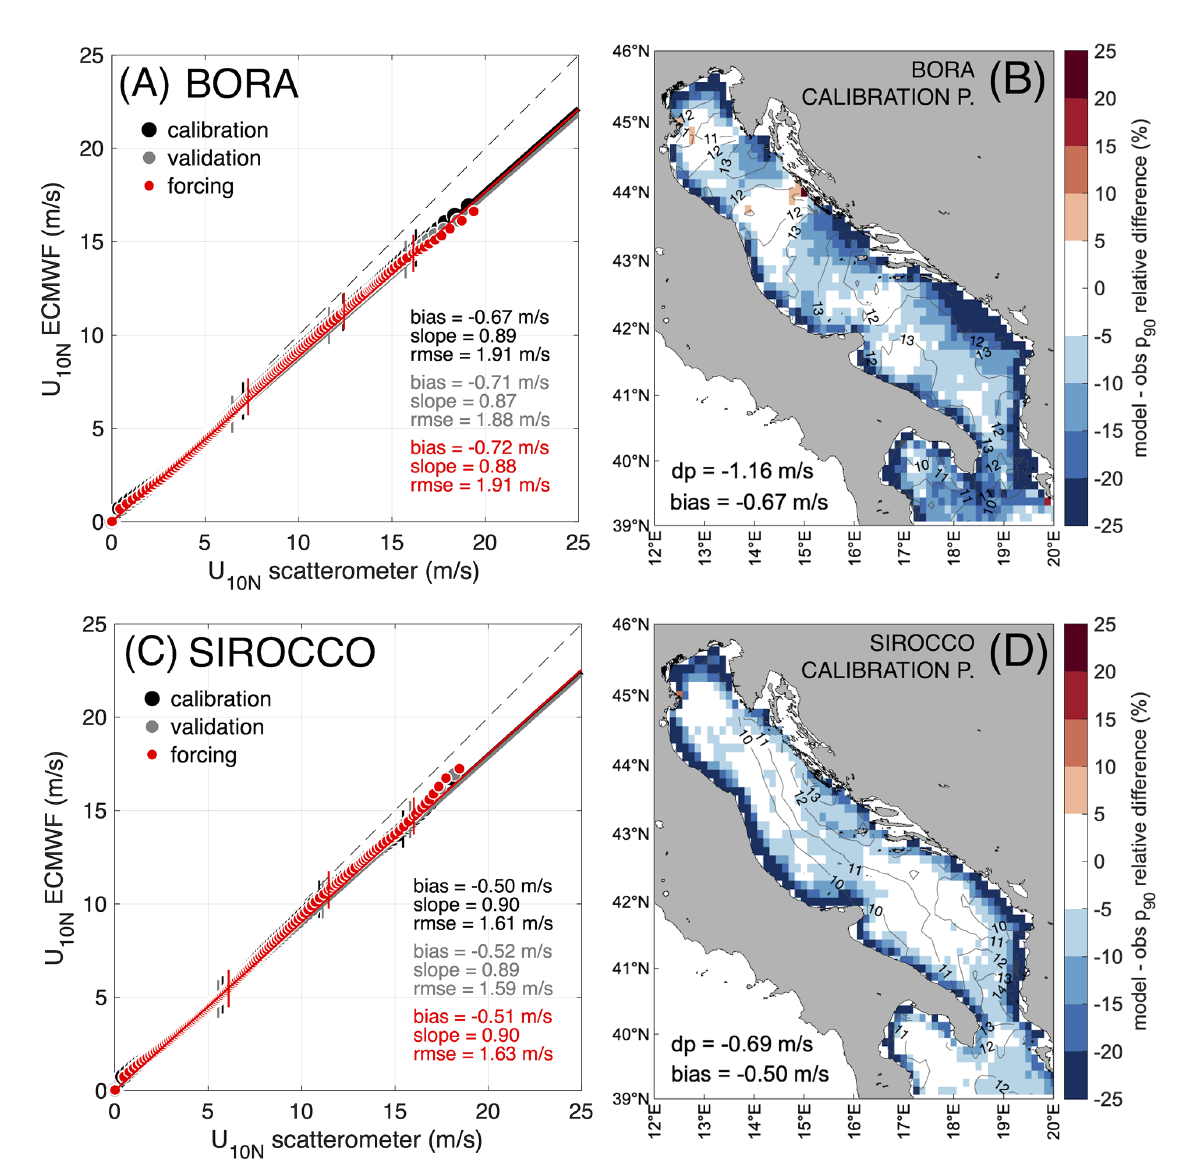
FIGURE 2 Comparison of wind speed U 10 N from scatterometers and from IFS-ECMWF model (closest forecast) co-located on observations. Quantile- Quantile plots of Bora (A) and Sirocco winds (C) during wind calibration (black), wind validation (grey) and WW3 forcing periods (red; see Table 2). Statistical indicators of model performance: bias , root mean square error ( rmse ), and slope of the best- fi t regression line ( slope ); see Appendix 1 for de fi nition. Vertical bars represent (from left to right) the 50 th , 90 th and 99 th percentiles of the datasets. Model-observation 90 th percentile wind speed relative difference maps (%) during the calibration period for Bora (B) and Sirocco (D) . dp is the relative difference of the ensemble 90 th percentile, bias is the bias of all the model with respect to the observed data. Contour lines are the observed wind speed 90 th percentile